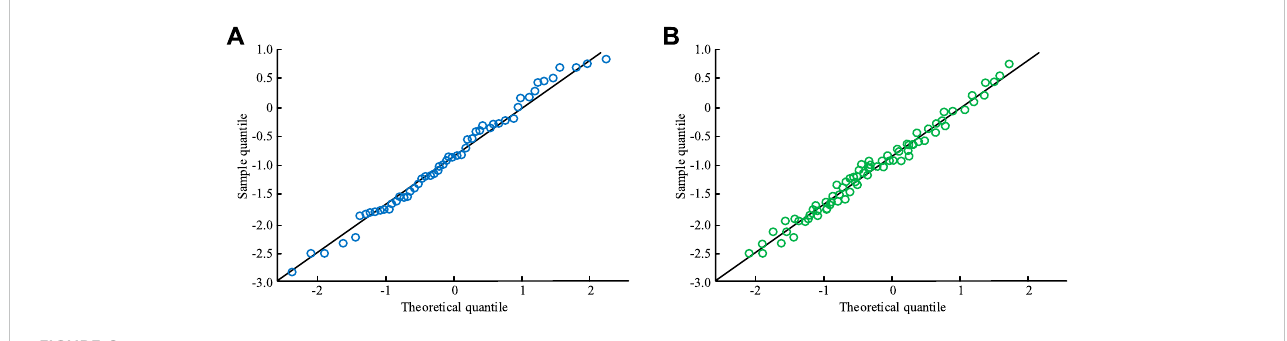
FIGURE 6 Normal distribution QQ chart of total carbon emissions and per capita carbon emissions. (A) Total carbon emissions. (B) Carbon emissions per capita .